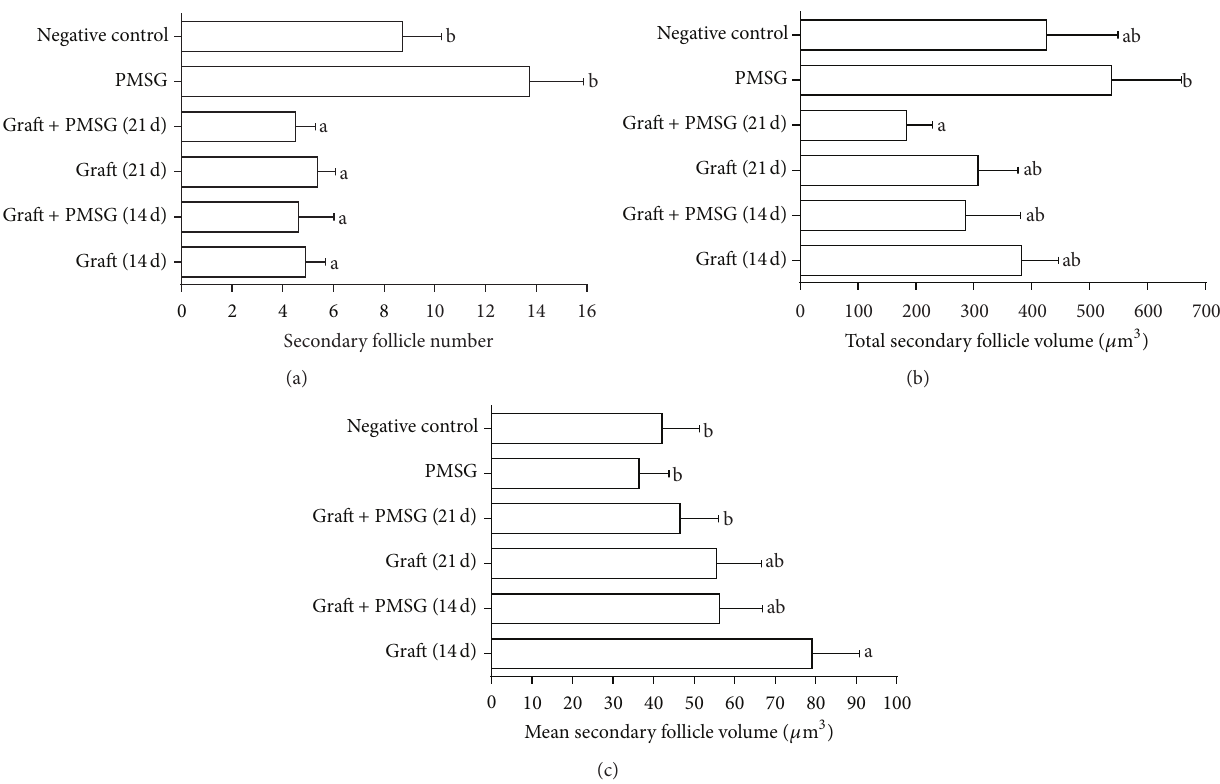
Figure 4: Mean and standard error of histomorphometric analysis of secondary follicles (a) total number, (b) total volume, and (c) mean follicle volume in control group, pregnant mare serum gonadotropin (PMSG) group, transplantation (14 and 21d), and PMSG/transplantation (14 and 21d) groups after autologous ovarian transplantation and superovulatory effect of PMSG. a , b Different superscript letters show significant difference between different groups ( 𝑃 < 0.05